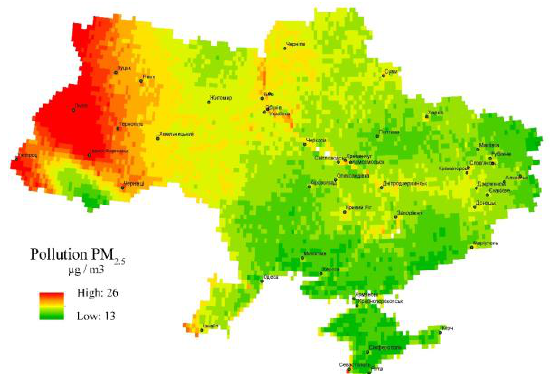
Figure 3. The relationship between the API data and NO2 pollution in the studied locations.